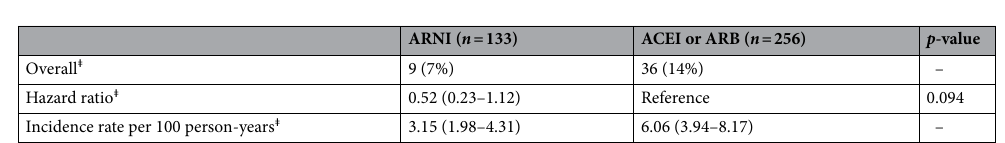
Table 3. The initiation of insulin therapy in patients with diabetes, not receiving insulin at the baseline. ǂ Data are expressed as the number of subjects (%) and ratio (95% CI). Adjusted variable: creatinine, age, SGLT2 inhibitors.